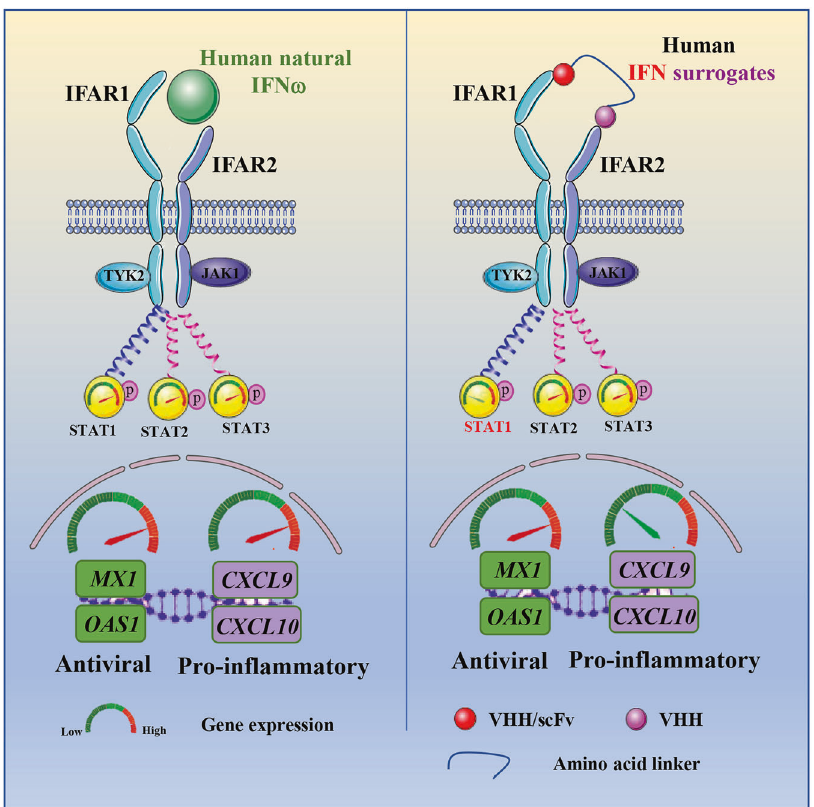
Fig. 1 The bispeci fi c type-I interferon surrogate ligands exhibit antiviral and pro-in fl ammatory effects discriminately. Human IFN surrogates ligands induced decreased activation of pSTAT1 but equivalent activation of pSTAT2 and pSTAT3 compared to the natural human IFN ω in vitro. HIS agonists induced comparable levels of the antiviral genes as natural human IFN ω but minimal expression of pro-in fl ammatory genes. VHH single variable domain of a heavy-chain, scFv single chain antibody